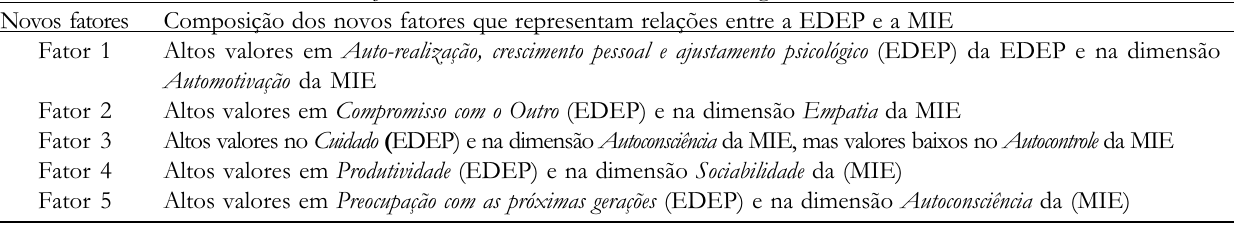
Estrutura Fatorial Resultante da AnÆlise Conjunta dos Itens dos Fatores da Medida de InteligŒncia Emocional e da Escala de Desenvolvimento Pessoal Novos fatores